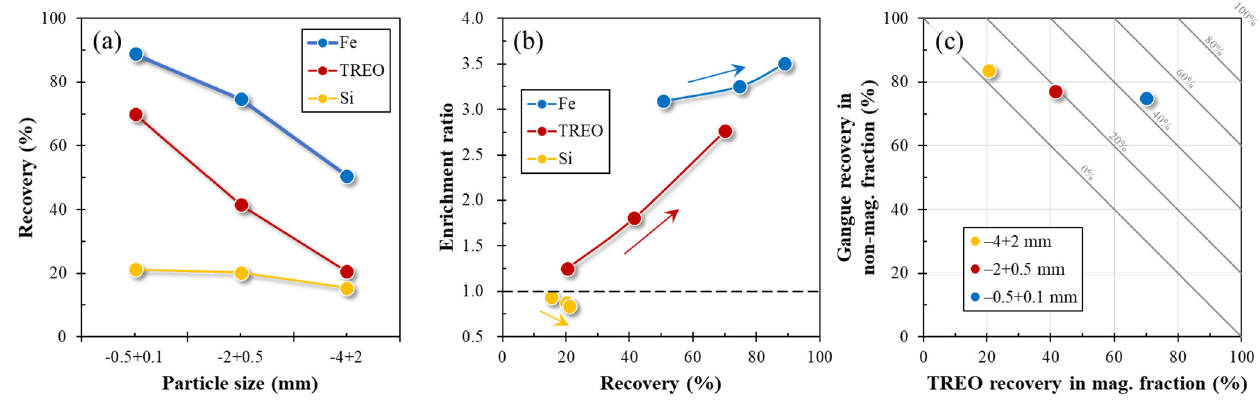
Figure 6. Effect of particle size on ( a ) the recovery of TREO, Fe, and Si from REE ore, ( b ) enrichment ratios of TREO, Fe, and Si as a function of recovery, and ( c ) relationship between TREO recovery in magnetic fraction and gangue recovery in non-magnetic fraction. Note: The arrows in Figure 6b indicate the particle size decreasing from − 4 + 2 mm to − 0.5 + 0.1 mm.